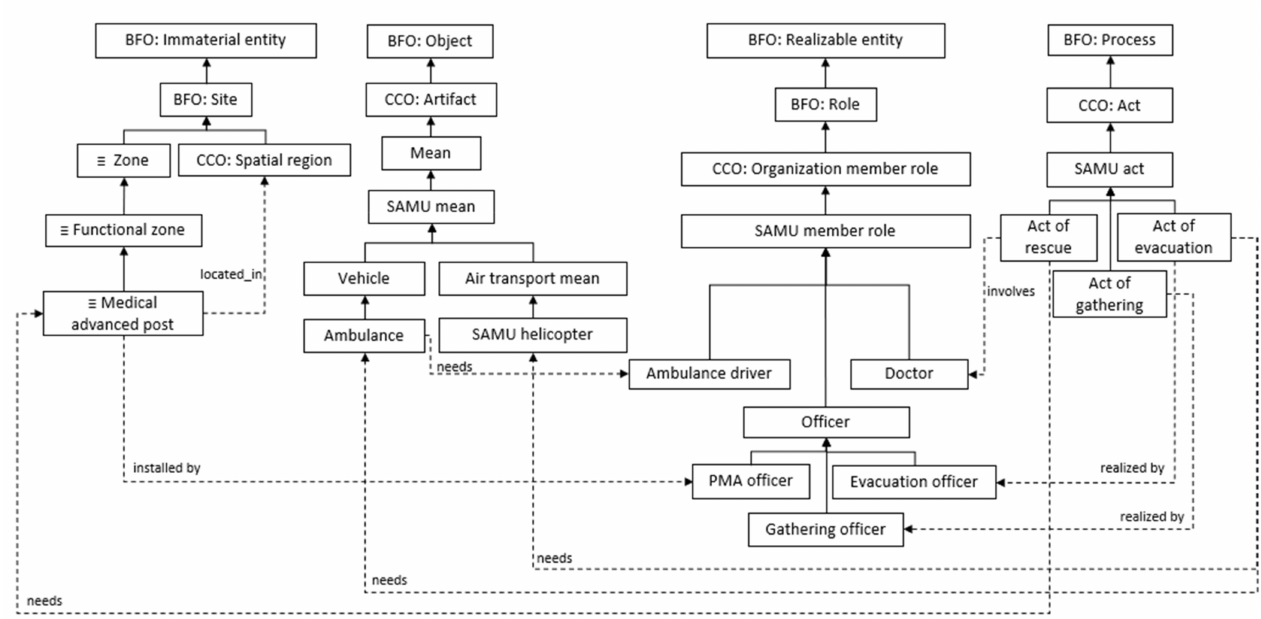
Figure 13. Acts, roles, and means in the healthcare units